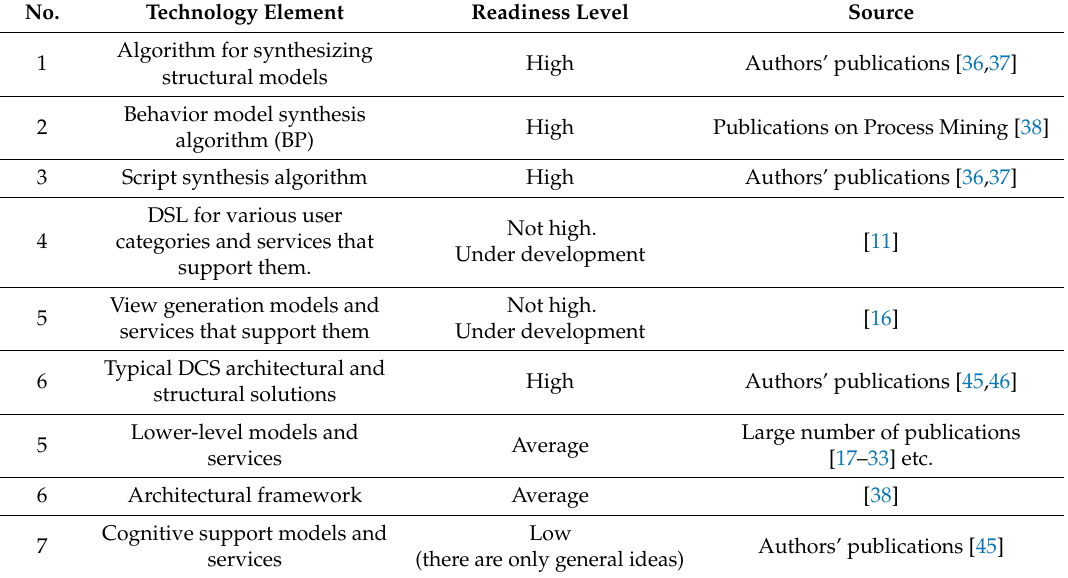
Table 3. Degree of readiness of Model Based Technology (MBT) technology